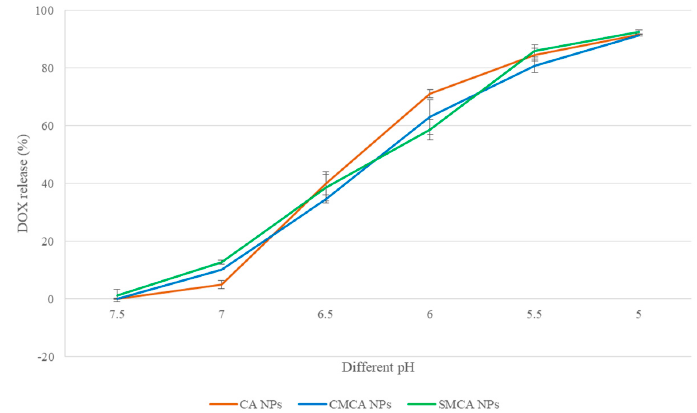
Figure 14. pH-dependent DOX-release from CA, CMCA and SMCA NPs.